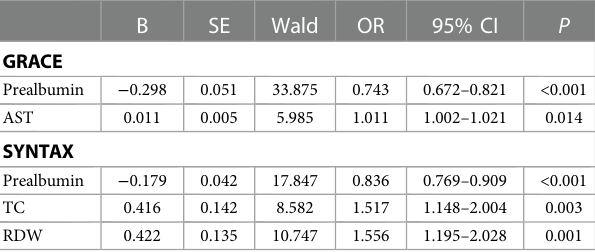
TABLE 4 Multivariate logistic analyses for important predictors of comprehensive clinical risk and severity of coronary lesions through GRACE and SYNTAX scores in ACS patients.